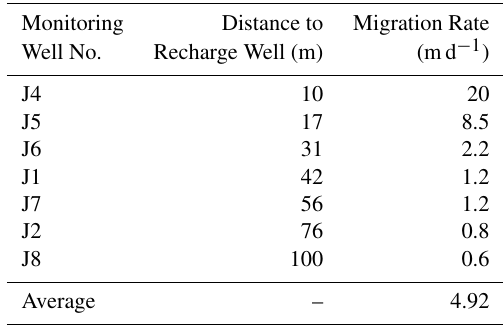
Table 2. Cl − ion diffusion rate of each monitoring well. Monitoring Distance to Migration Rate Well